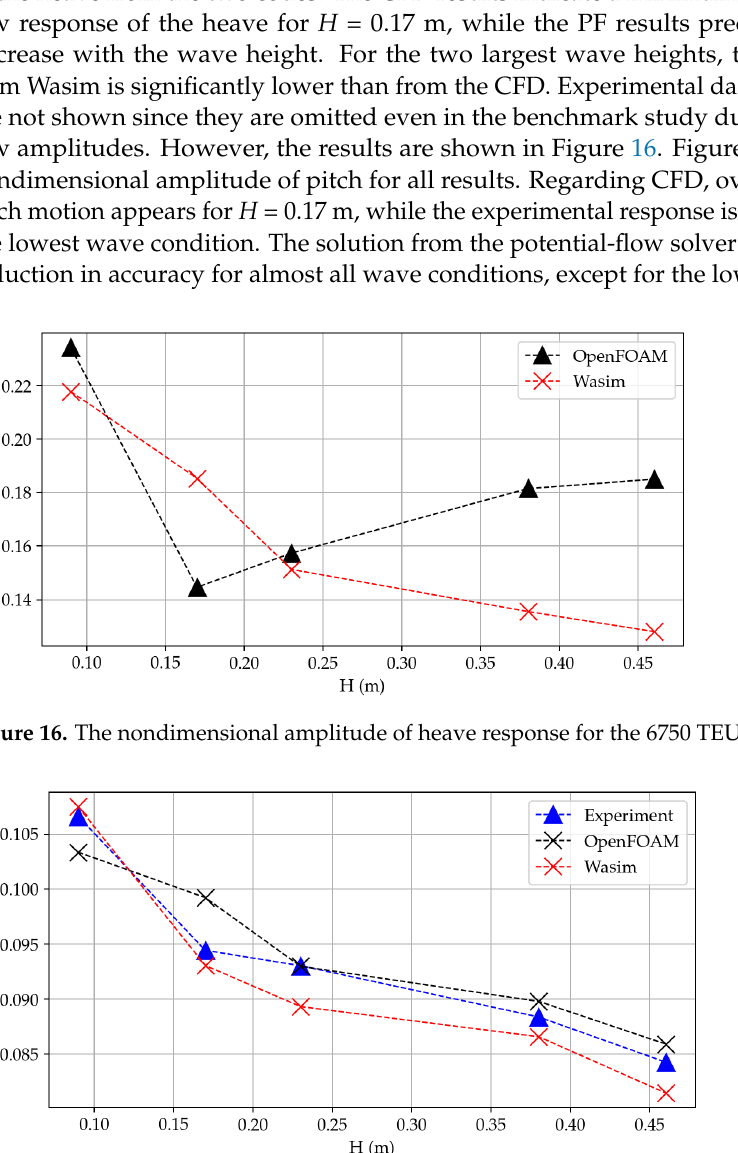
Table 7. Difference of nondimensional numerical and experimental pitch amplitudes for the 6750 TEU containership. H , m